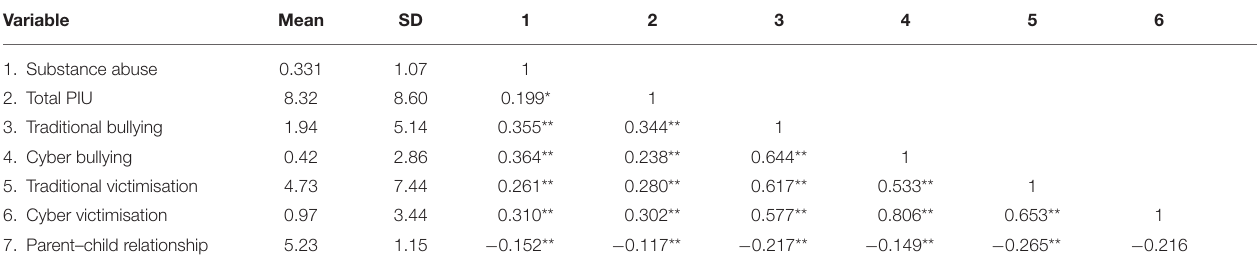
TABLE 1 | Descriptive statistics and correlations among the main variables ( N = 1,613). Variable